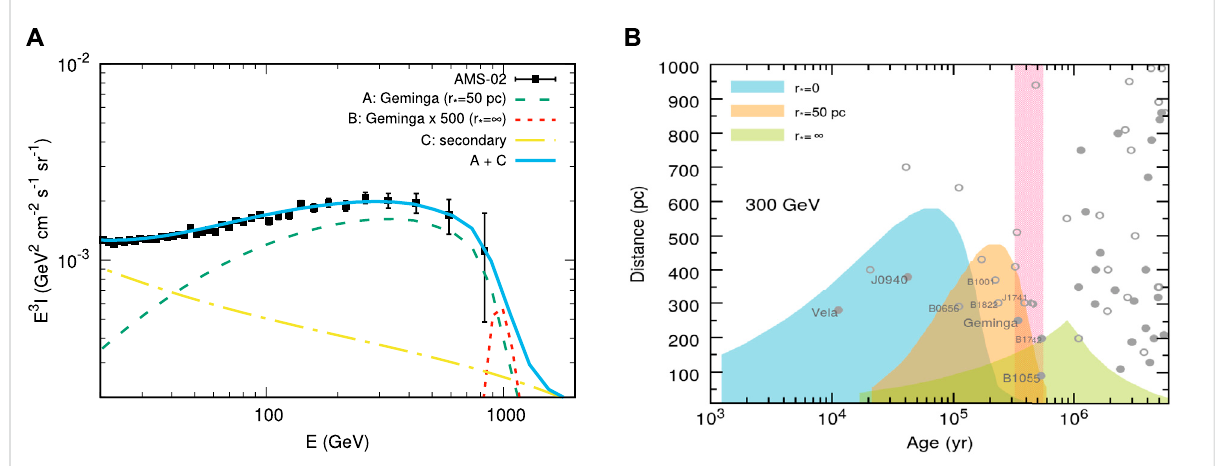
FIGURE 6 (A) Interpretation of the positron excess with Geminga under the two-zone diffusion model ( r + = 50 pc). The result of the one-zone slow- diffusionmodel( r + = ∞ )isalsoshownforcomparison.This fi gureisadaptedfromFangetal.(2018). (B) Contoursofthepositron fl uxat300 GeVasa function of pulsar age and distance. Pulsars inside the shaded areas are those can contribute more than half of the measured fl ux of AMS-02 at 300 GeV. Three different models are presented with different colors. The red band indicates the range of the cooling time corresponding to positron spectral cutoff measured by AMS-02 (Aguilar et al., 2019). One may refer to Fang et al. (2019b) for further details of this fi